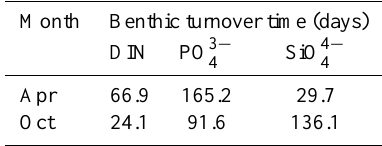
Table 3. Benthic turnover time for DIN, PO 3 − April and October at station